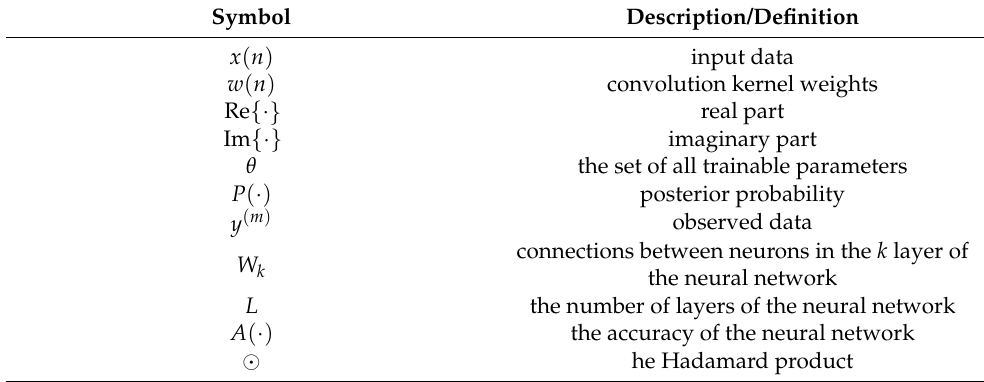
Table 2. Symbols and their brief description/definition in Section